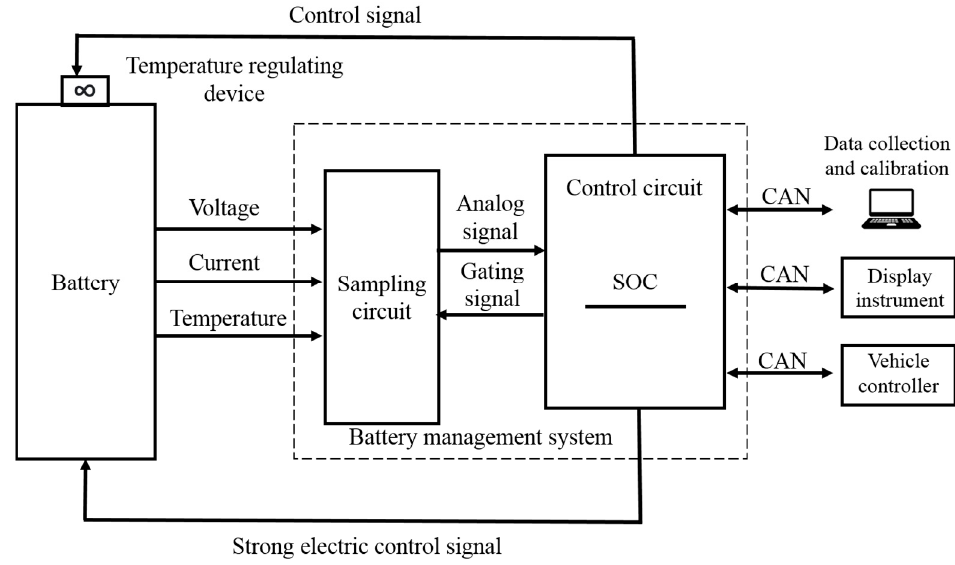
Figure 2. Schematic diagram of a typical BMS [26].